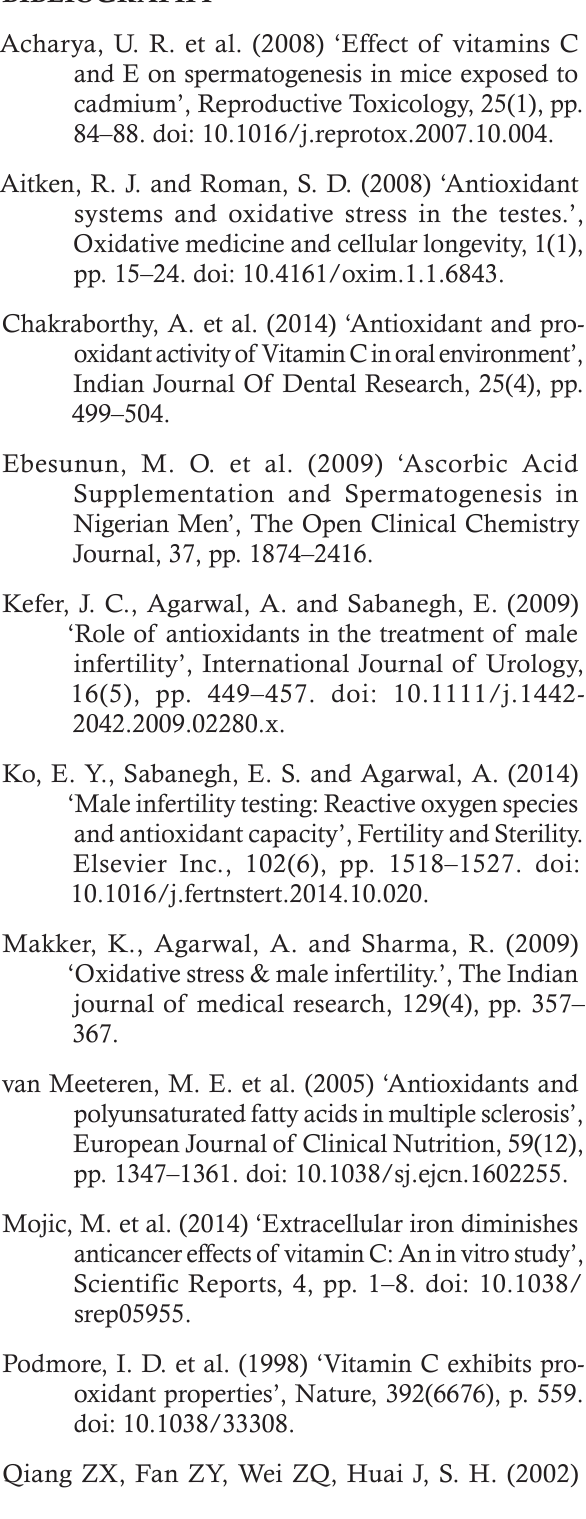
High Dose Vitamin C Administration Effect in Leydig